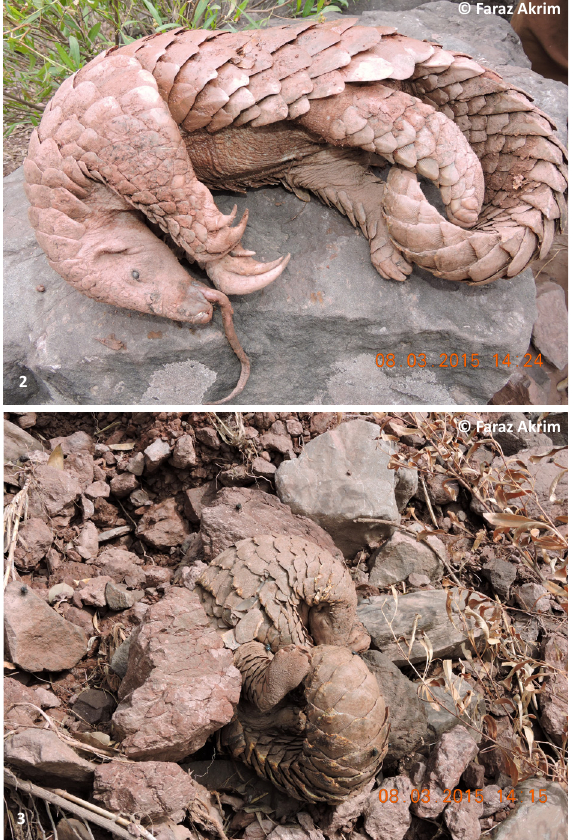
Table 1. Population estimates of Indian Pangolin in and around Pir Lasura National Park, Azad Jammu & Kashmir, Pakistan during